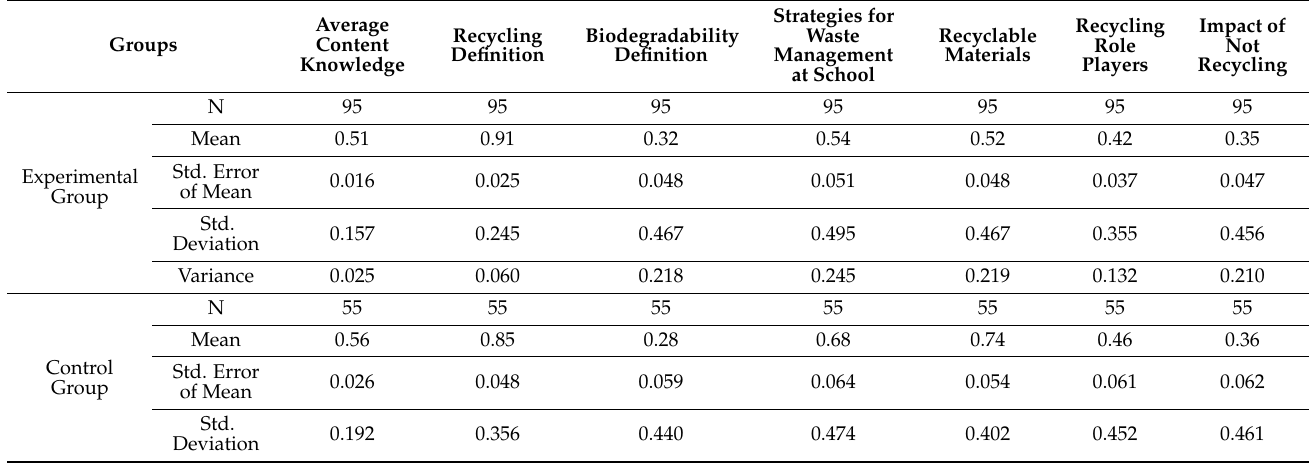
Table 2. Pre-test results comparing learner performance in the experimental and control group. The table shows learners’ performance scores in the different topics assessed in the research.